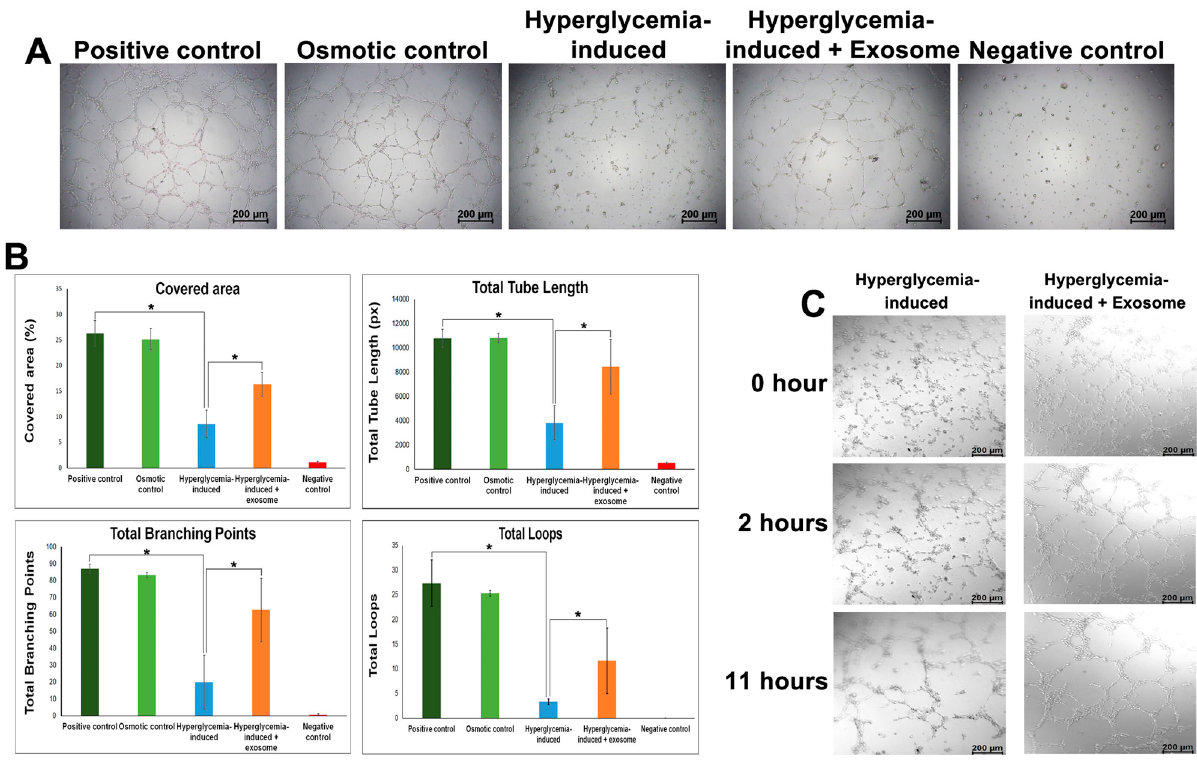
Figure 3- SHED-derived-exosome promotes tube formation in high glucose concentration-treated HUVEC. (A) Capillary-like network structures in 6 hours were examined using Matrigel tube formation. Scale bars = 200 µm. (B) Quantification of tube length, number of tube branching points, covered area, and number of loops in the network structures of HUVEC in A were analyzed using WimTube image analysis software. * indicates a statistically significant difference between the group of high glucose concentration-induced and positive control (p<0.001) and between the group of exosomes and no exosome treatment in high glucose concentration-induced (p=0.03). (C) Representative images from the live tube formation were captured of uncontrolled blood glucose concentration-treated HUVEC with and without SHED-exosome treatment at 0, 2, and 11 hours. Scale bars = 200